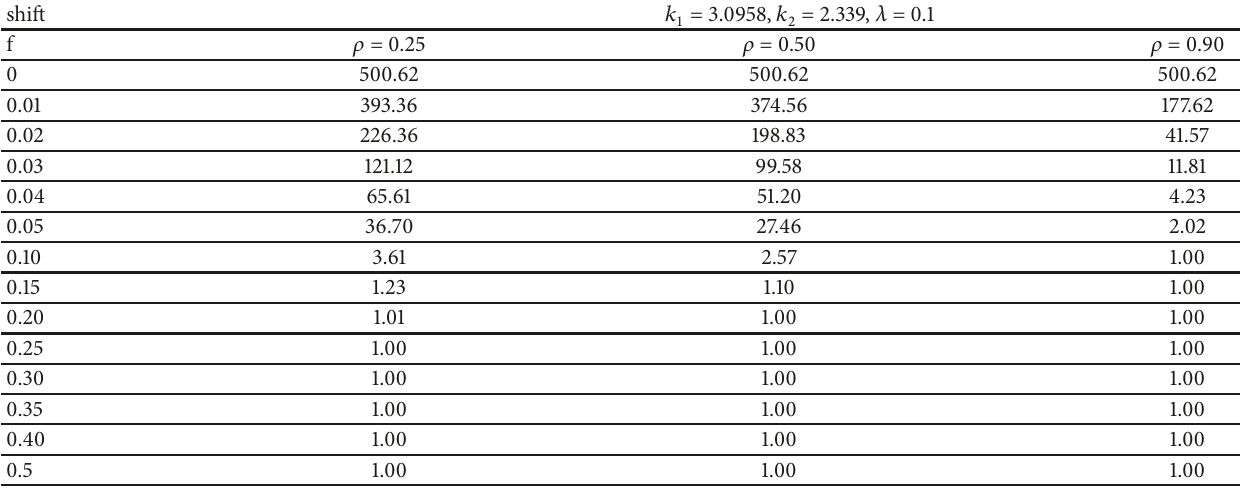
Table 7: ARLs for proposed repetitive EWMA-RSS control chart using Khan et al. [8] exponential ratio-type estimator, when 𝑟 𝑜 is 500. shift